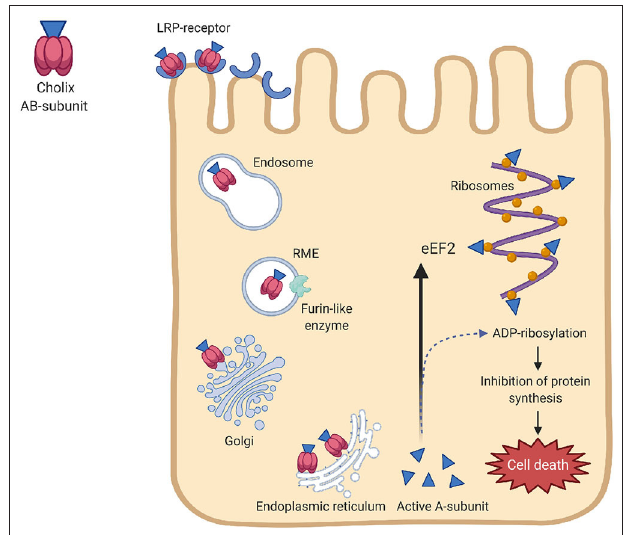
FIGURE 3 | Mechanisms of action of cholix toxin. Chx binds to the lipoprotein receptor-related protein (LRP-receptor) of the eukaryotic cells, followed by internalization by receptor-mediate endocytosis (RME). A furin-like enzyme is believed to be responsible for nicking cholix in its arginine-rich loop. After passing the Golgi complex, cholix follows the retrograde pathway in the endoplasmic reticulum to form the A and B-subunits. The A-subunit translocate into the cytoplasm and prevents protein synthesis by altering the diphthamide residue of elongation factor 2 (eEF2) through its ADP-ribosylation activity. Inhibition of protein synthesis by specific modification of eEF2 leads to cell